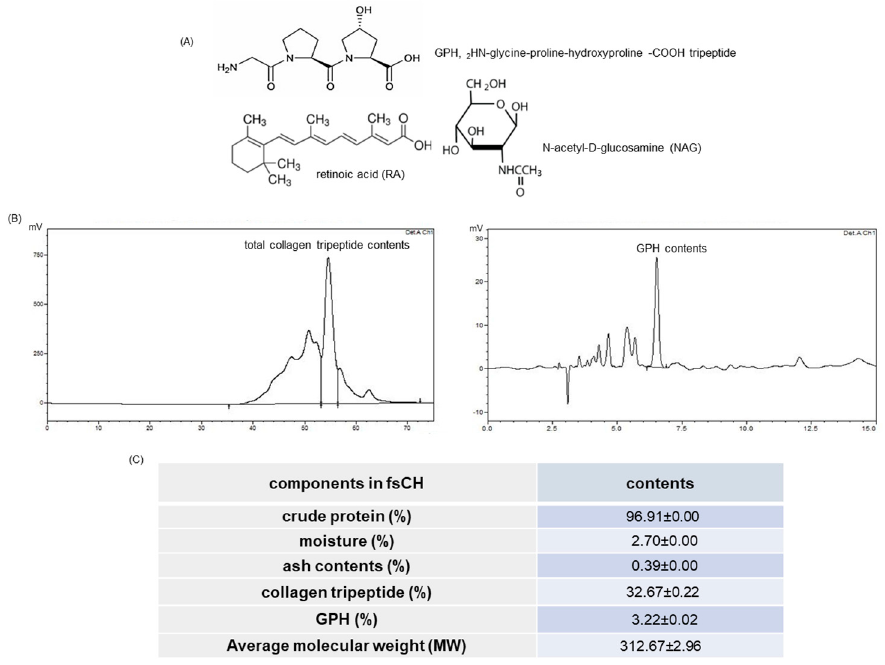
Figure 1. ( A ) Chemical structures of glycine-proline-hydroxyproline tripeptide (GPH), retinoic acid (RA), and N-acetyl-D-glucosamine (NAG) and the HPLC spectra ( B ) and contents ( C ) for total collagen tripeptides and GPH obtained from Pangasius hypophthalmus fish skin hydrolysates (fsCH), by using SuperdexT TM Peptide 10/300GL column and Zorbax SB-AQ column. The peaks of collagen tripeptides and GPH were identified by the ultraviolet contour plot obtained by a photodiode-array detector at the wavelengths of 214 and 220 nm.